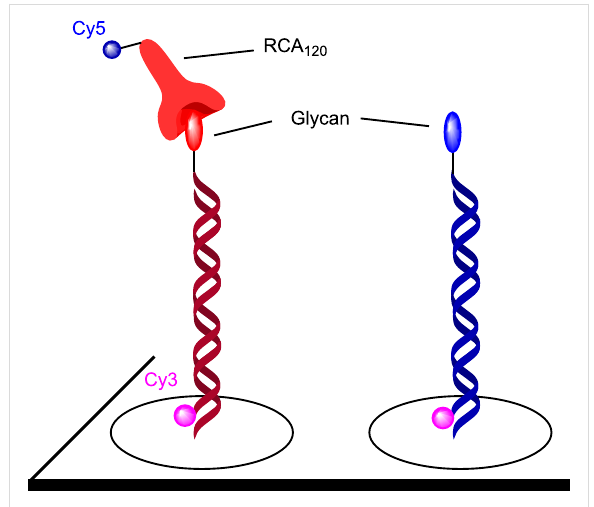
Figure 6: A glycan array prepared by hybridization of glycan–DNA conjugates and screening of RCA 120 .